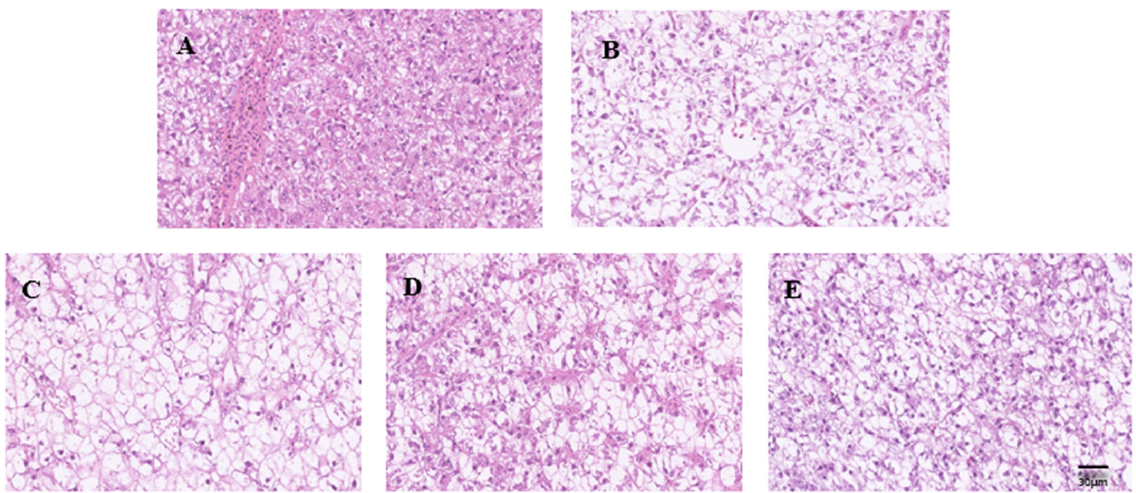
Figure 1. Effects of GTF on morphological changes of liver tissue of tilapia at different concentrations